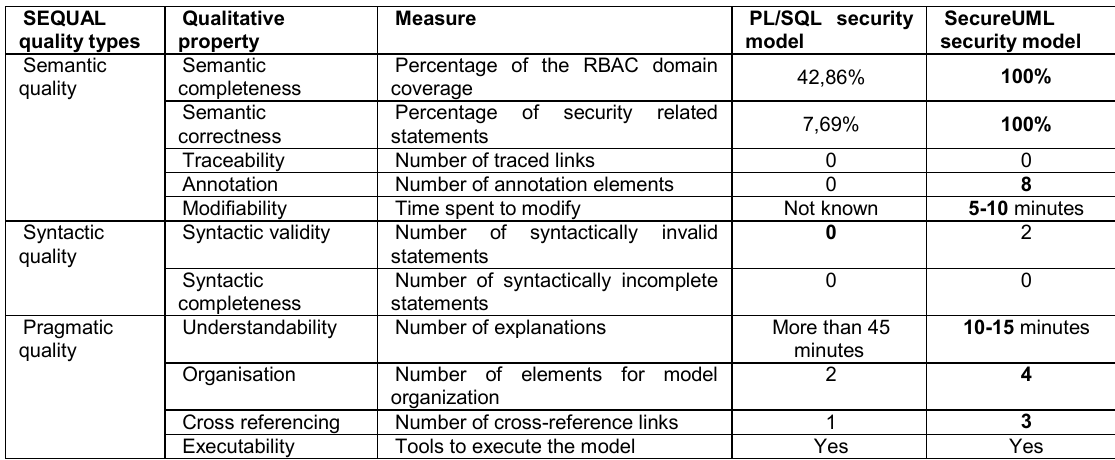
Table 2. Quality assessment results (the highest score is in